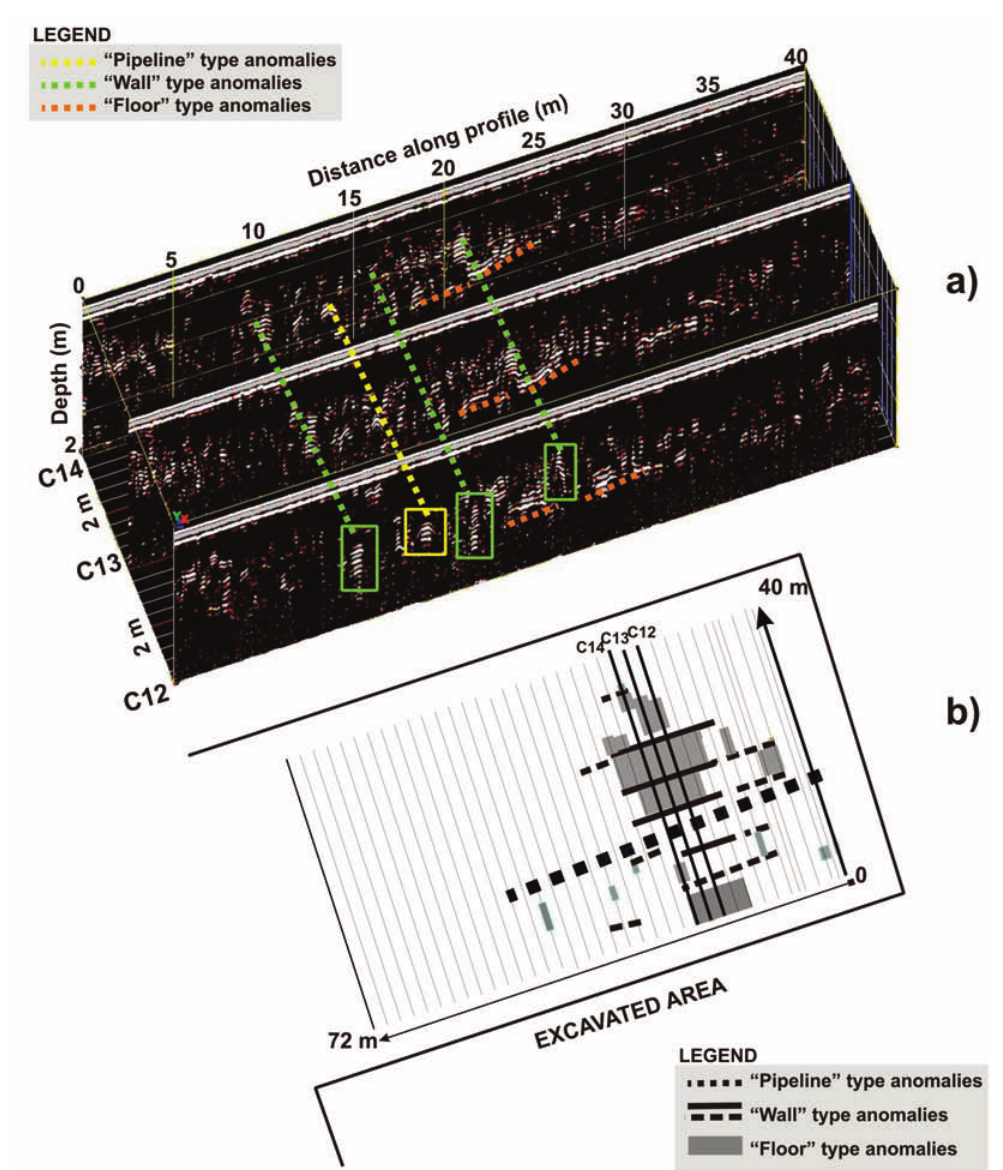
Figure 3. Map from the GPR survey. (a) Example of the anomaly consistency along three profiles (C12, C13, C14). (b) Planimetry of the main GPR